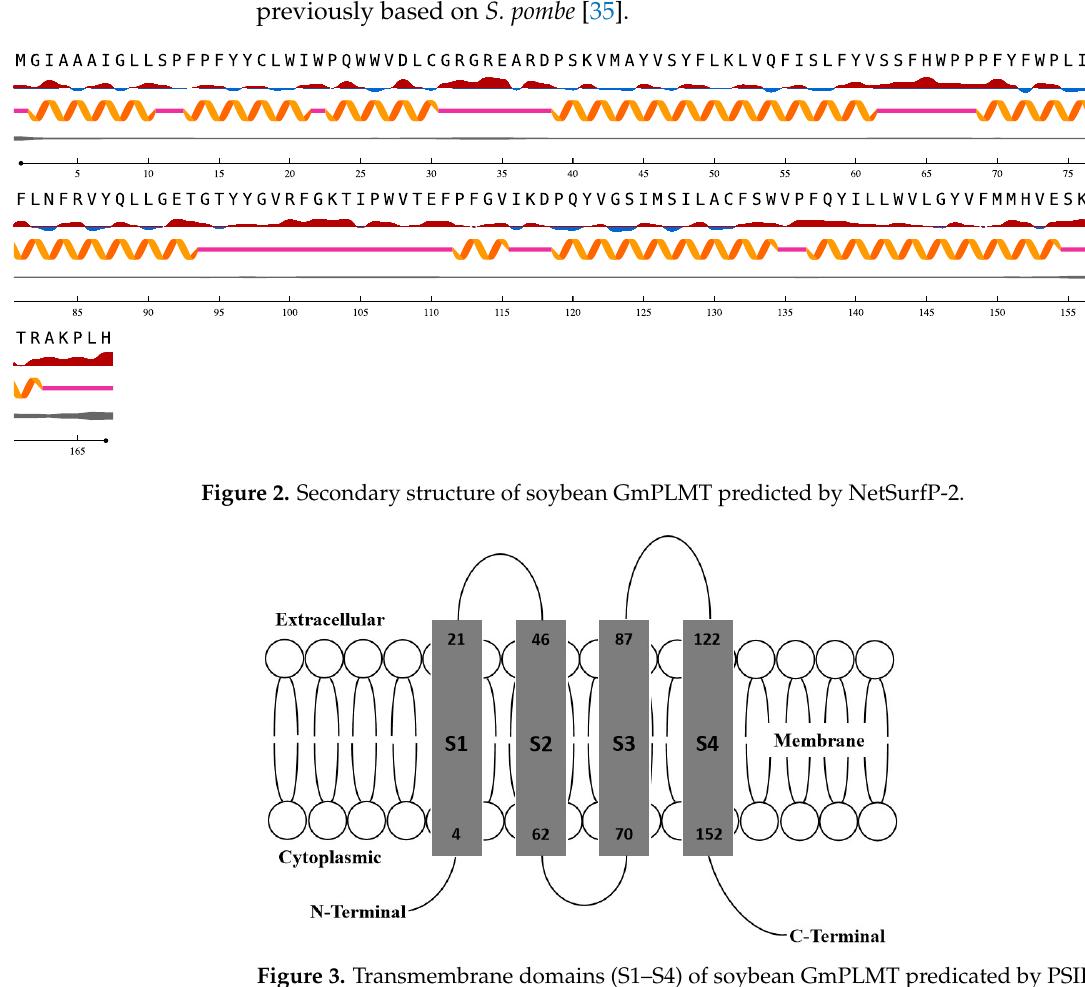
Figure 3. Transmembrane domains (S1–S4) of soybean GmPLMT predicated by PSIPRED4.0.